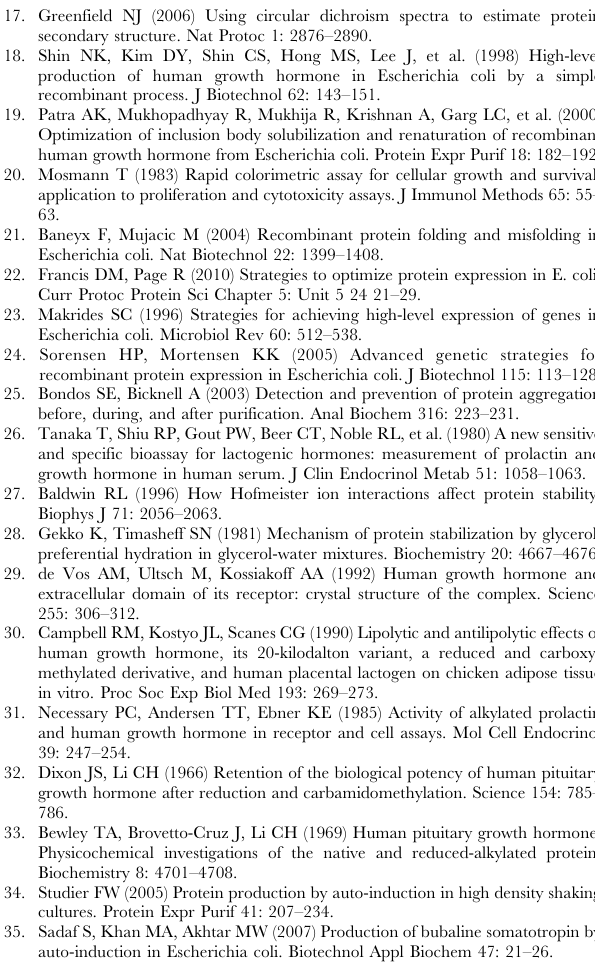
Figure S1 Solubility comparison of recombinant hGH expressed at different IPTG concentrations. The levels of soluble hGH induced at various IPTG concentrations were quantified and graphed by a densitometry assay using Image- Quant TM TL 5.2 analysis software. Table S1 Purification of His-hGH from E. coli . Table S2 Purification of untagged hGH from E. coli